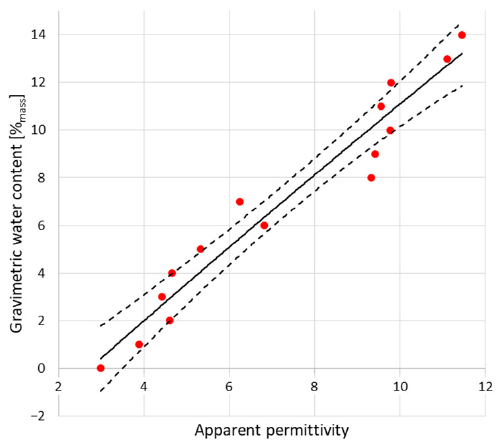
Figure 9. Dependence between relative permittivity readouts using microwave antenna and mass moisture evaluated gravimetrically.